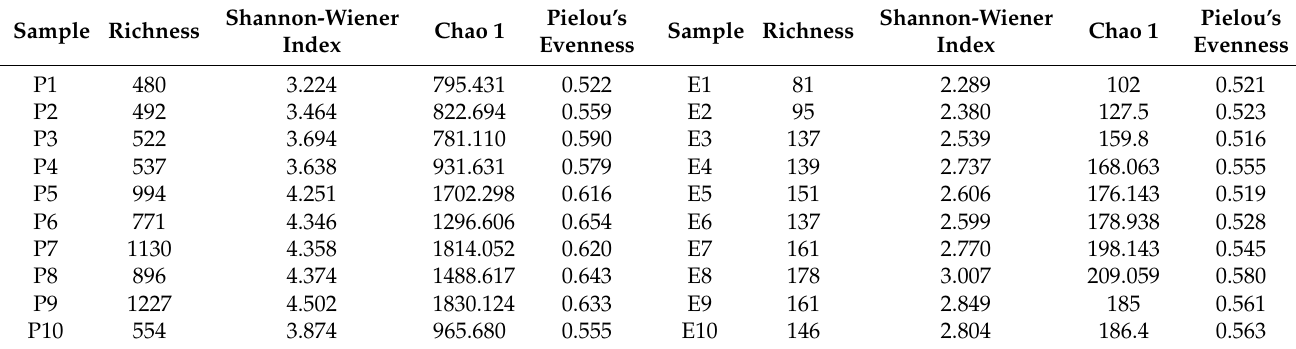
Table 1. Diversity of prokaryotic and eukaryotic communities.